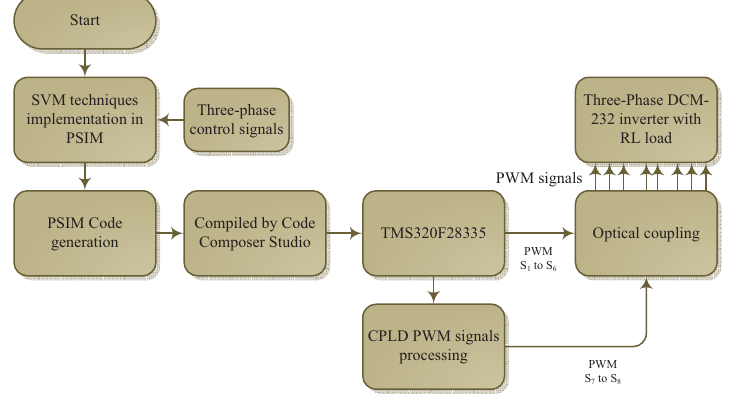
Figure 14. Flowchart for the experimental